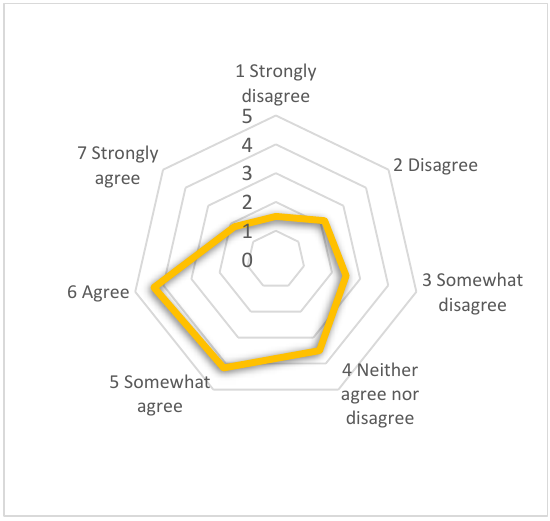
Figure 20. Realism assessment.